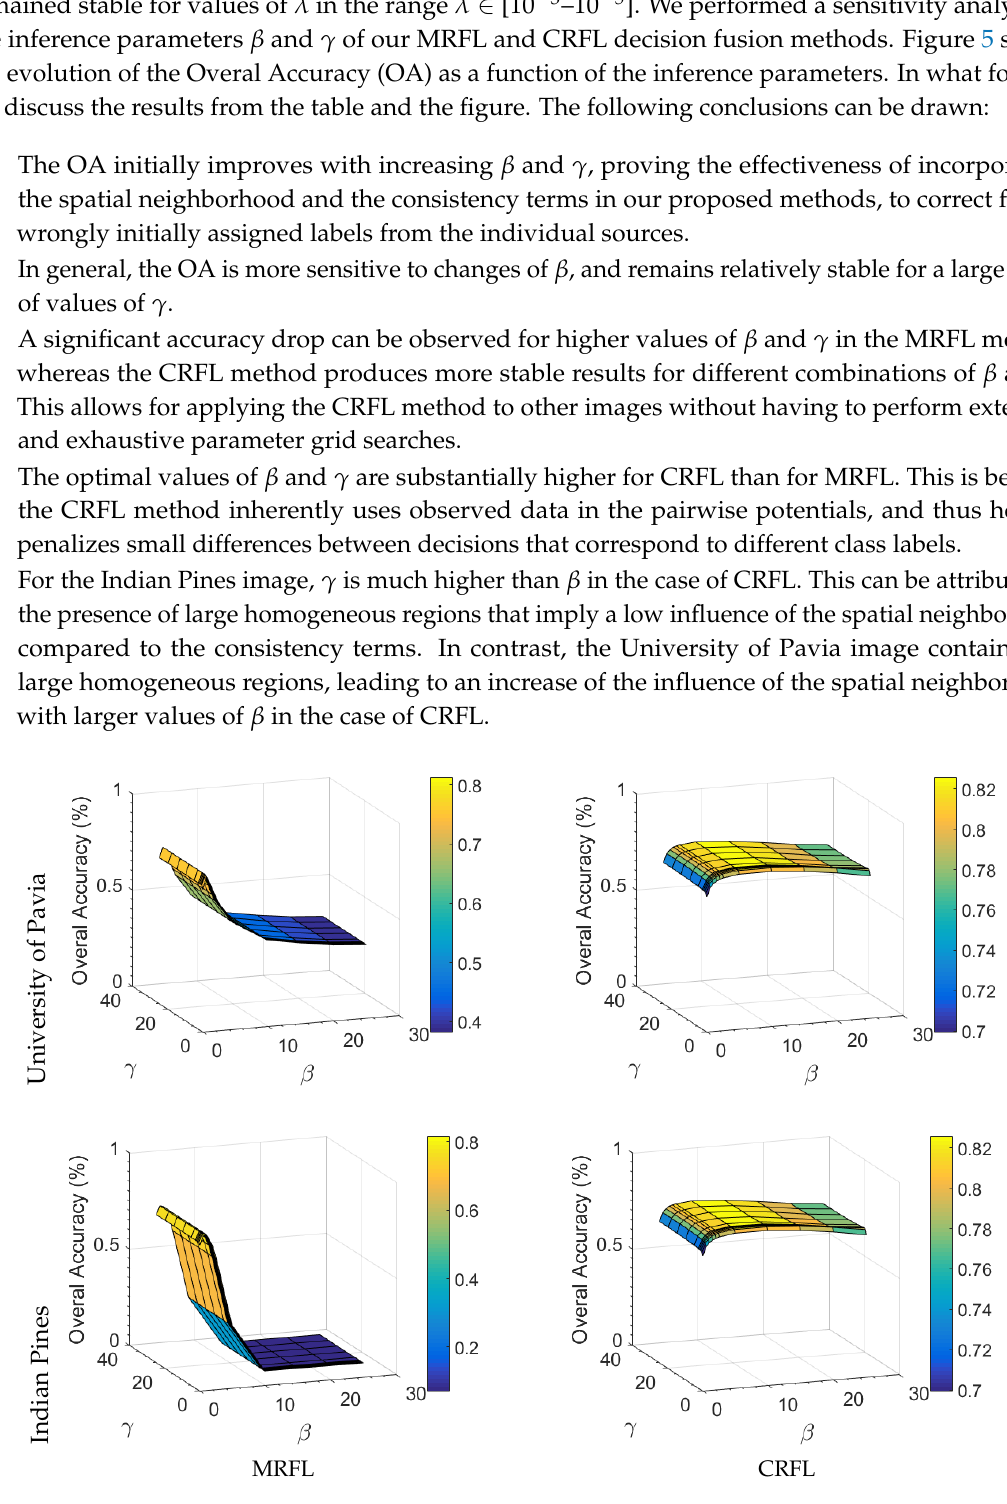
Figure 5. Effect of β and γ on the Overal Accuracy (OA) for both proposed methods: MRFL and